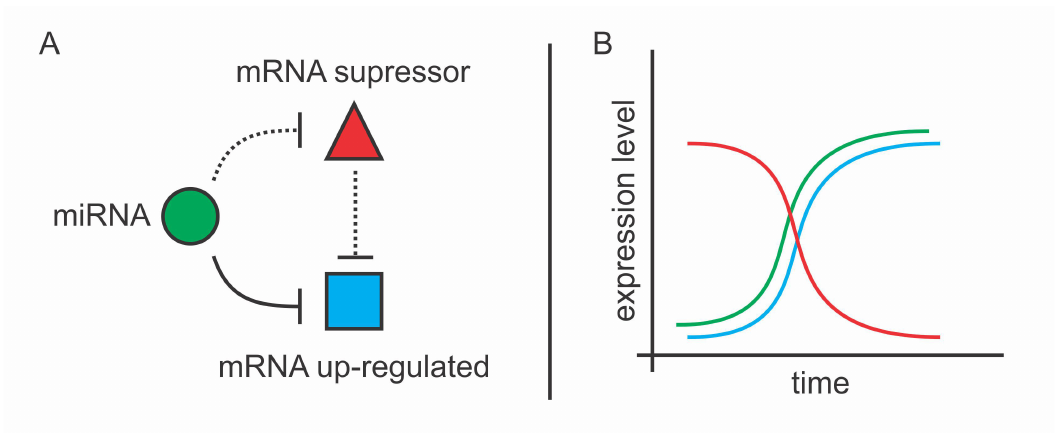
Figure 7. MiRNA-mediated mRNA up-regulation scheme. ( A ) Interaction network between the miRNA, the up-regulated mRNA, and its suppressor. The miRNA down-regulates mRNA suppressor while fine-tunes the expression of the up-regulated mRNA. The continuous line represents direct interaction and dashed line represents either direct or indirect regulation; ( B ) Representative expression variation of the network members. Green line represents miRNA expression, the blue line represents up-regulated mRNA expression and the red line represents mRNA suppressor